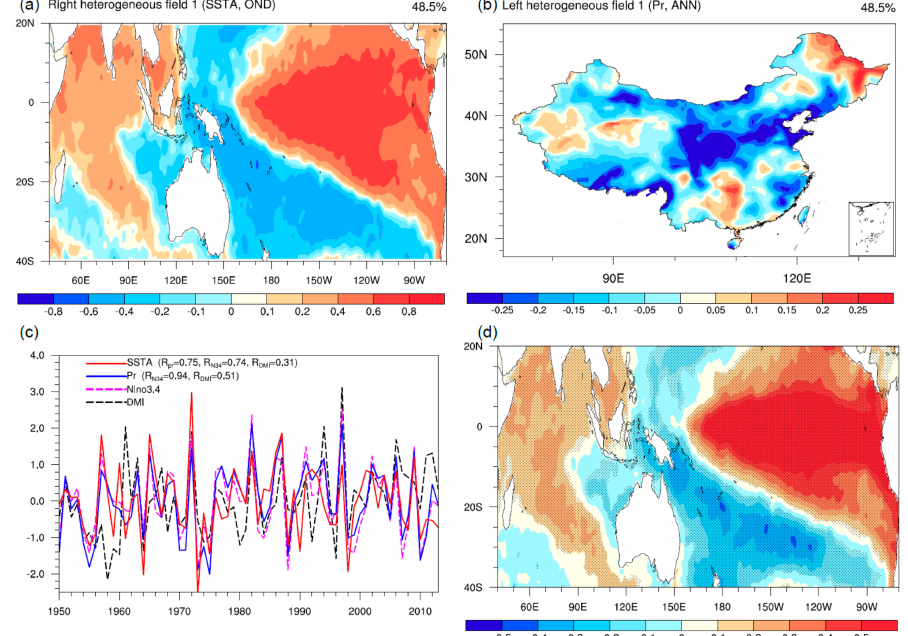
Figure 1. Heterogeneous regression patterns of the first singular value decomposition (SVD) mode for the de-trended and normalized ( a ) SST during October–November–December (OND), and ( b ) annual precipitation. ( c ) The normalized time series of the SVD expansion coe ffi cients of SST (red solid line) and precipitation (blue solid line), and seasonal indices of Nino3.4 (November–December–January (NDJ); pink dashed line) and Dipole Mode Index (DMI) (September–October–November (SON); black dashed line); Values shown in the parentheses indicate the correlation coe ffi cients among the two expansion coe ffi cient time series and Nino3.4 and DMI, respectively. ( d ) Regression of expansion coe ffi cient time series for the annual precipitation SVD pattern in ( c ) with OND SST. The stippling indicates statistically significant at the 90%